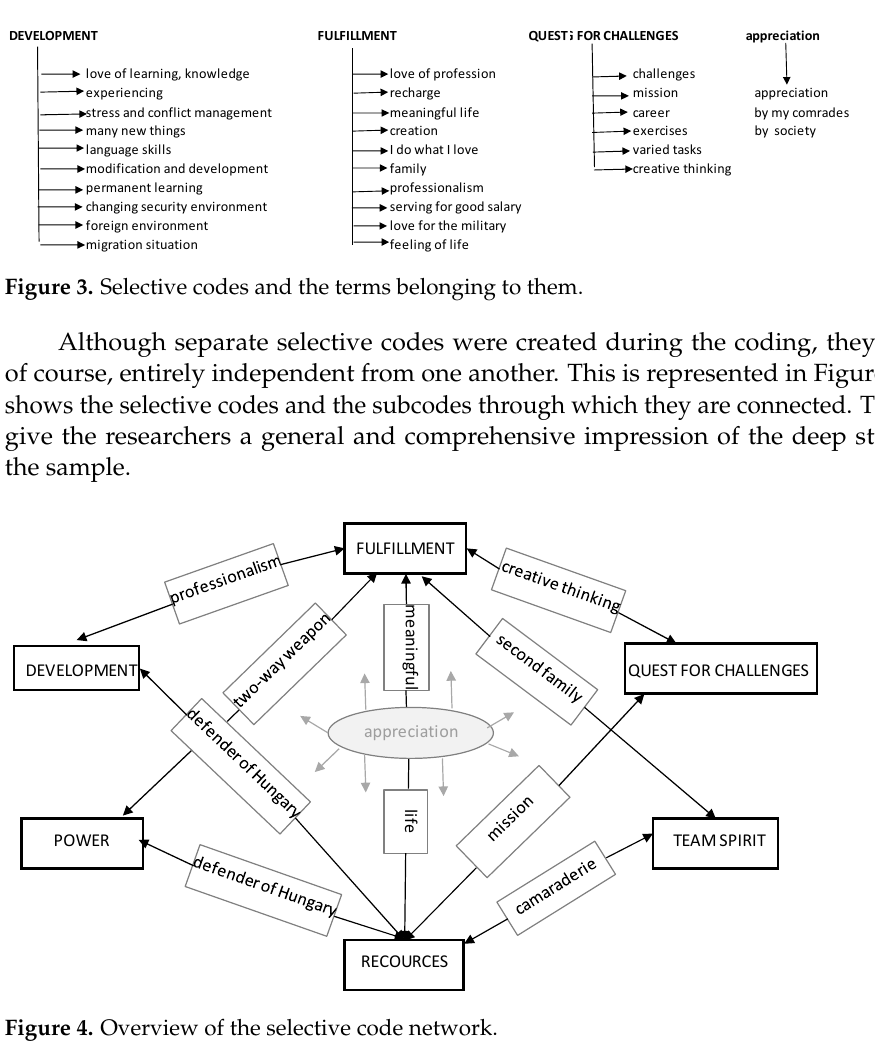
Figure 4. Overview of the selective code